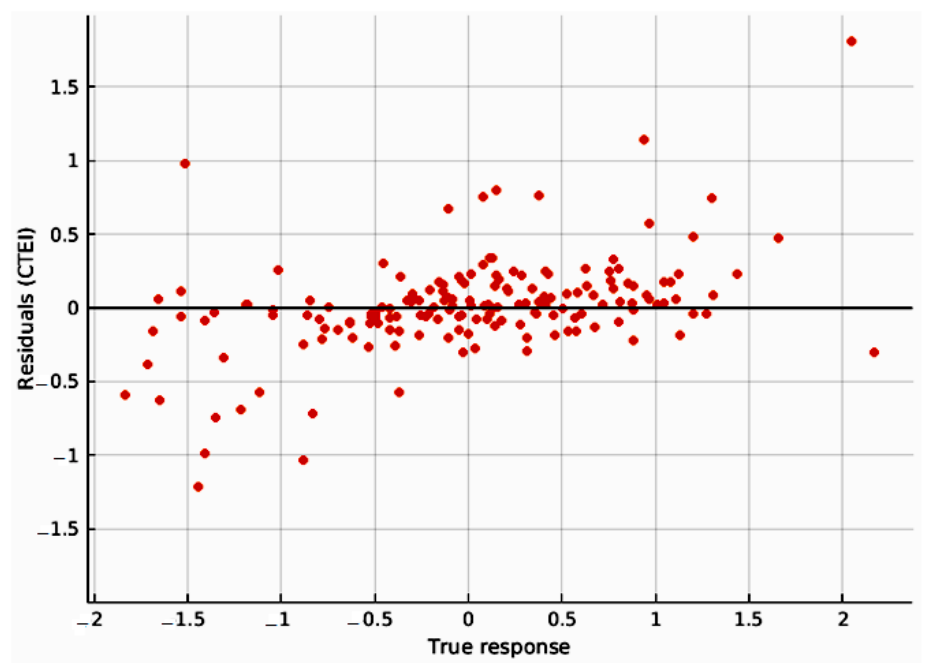
Figure 7. The residuals versus the Ganga basin’s actual values for the best model (model 8